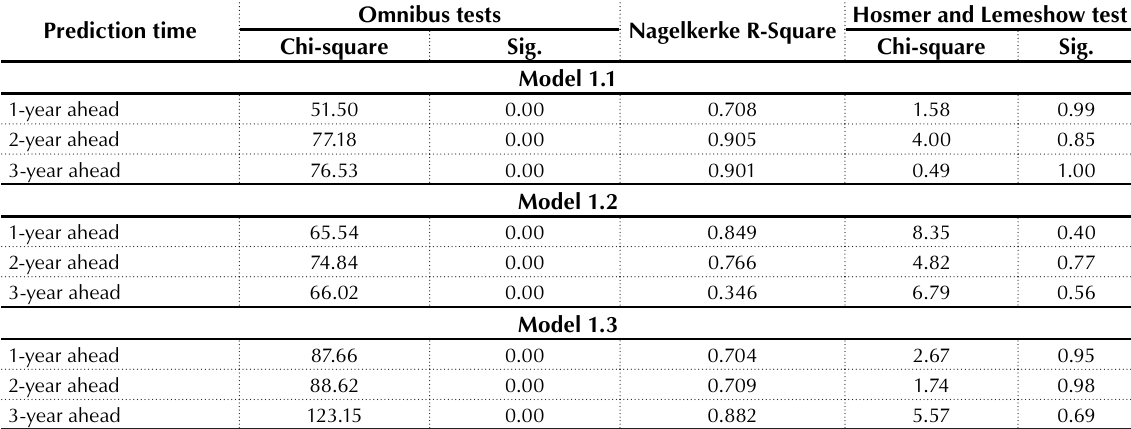
Table A6. Model’s overall significance – variable set 2 Prediction time